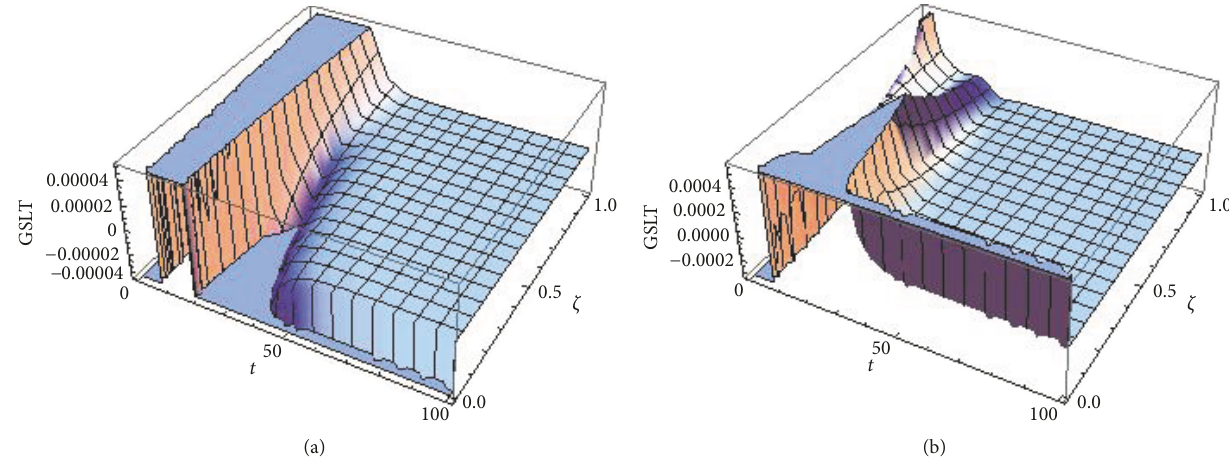
Figure 8: Validity of GSLT for the model (52). (a) is for 𝑑 1 = −1 with 𝑑 3 = 1 and (b) for 𝑑 1 = 𝑑 3 = −1